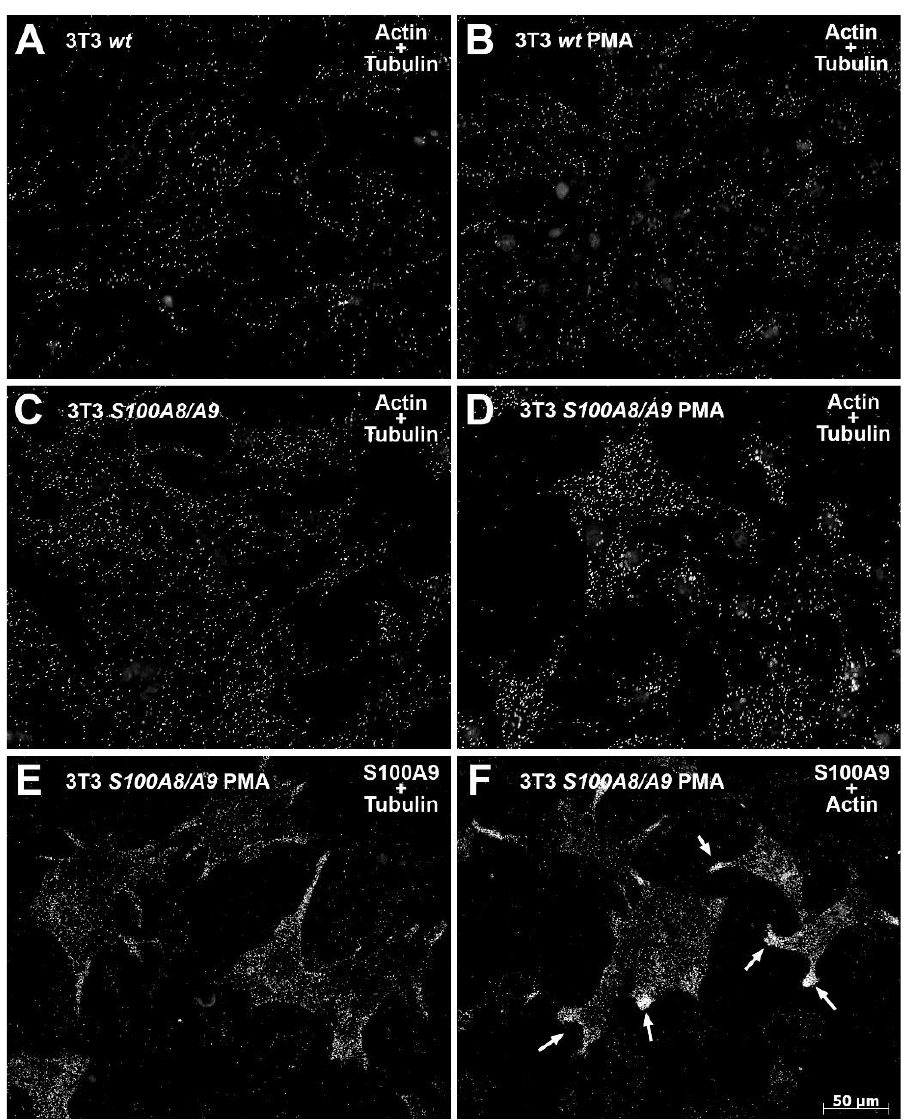
Figure 3. S100A8/S100A9 cross-linked F-actin and MTs in vivo. In the DuoLink ® PLA, each spot represents a direct interaction of the two analyzed proteins. In contrast to untransfected fibroblasts ( A , B ), the S100A8/S100A9-transfected NIH 3T3 cells ( C , D ) showed a higher degree of actin–tubulin interactions. Moreover, the wildtype cells showed no further increase in actin–tubulin interaction upon PMA-stimulation (10 nM/4 h) ( B ), whereas the opposite was found for S100A8/S100A9-expressing NIH 3T3 fibroblasts ( D ). S100A8/S100A9-expressing cells also showed distinct interactions of S100A9 with tubulin ( E ) and F-actin ( F ). Note the accumulation of signal/interaction events in areas of increased membrane dynamics (arrows). Three independent experiments were